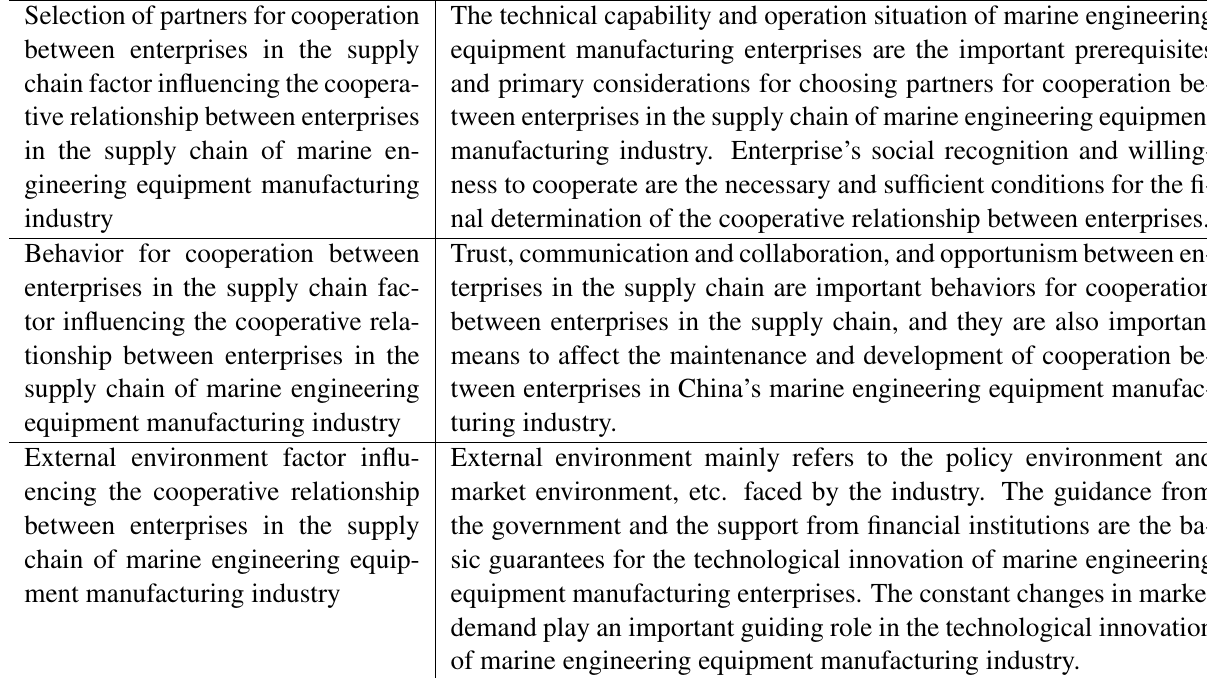
Table 2: Canonical relations of fundamental